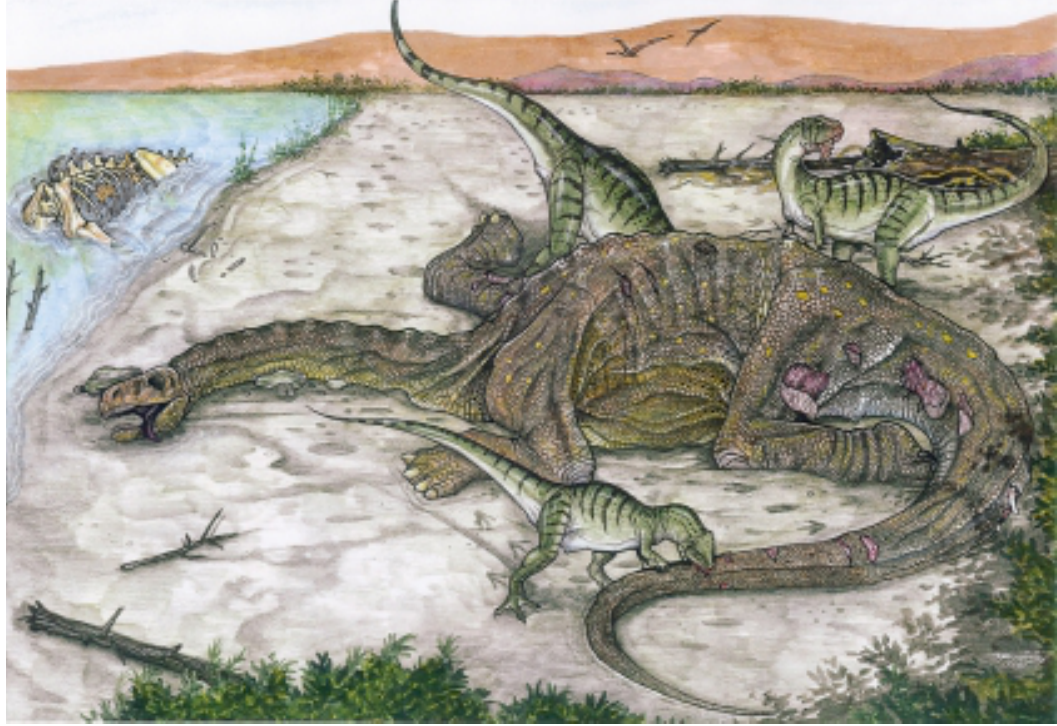
Fig. 22 – Hypothetical scene showing some of the dinosaurian faunal elements that lived in the State of São Paulo during the deposition of the Adamantina Formation (Upper Cretaceous, Bauru Group): the titanosaurid sauropod Gondwanatitan faustoi is scavenged by small abelisaurid-like theropods.